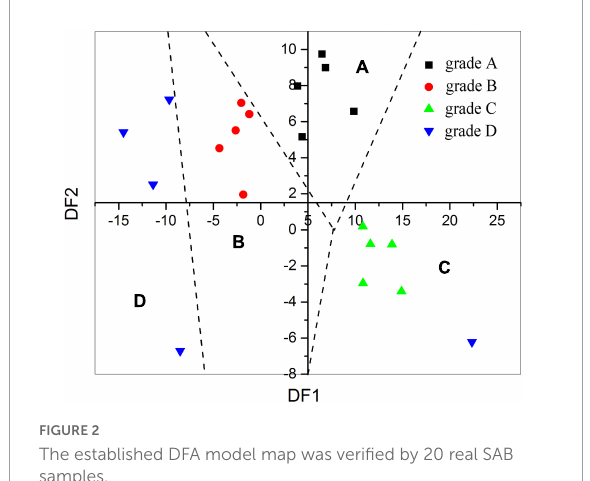
FIGURE2 The established DFA model map was verified by 20 real SAB